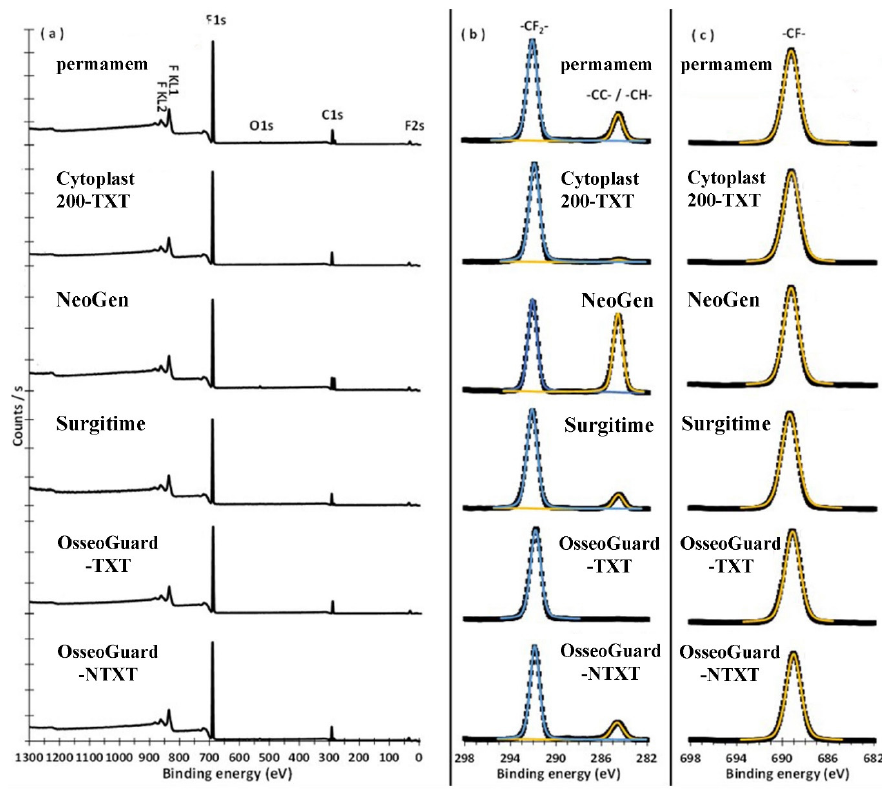
Figure 4. XPS spectra. ( a ) survey, ( b ) C1s, ( c ) F1s regions; TXT: textured; NTXT: non textured.